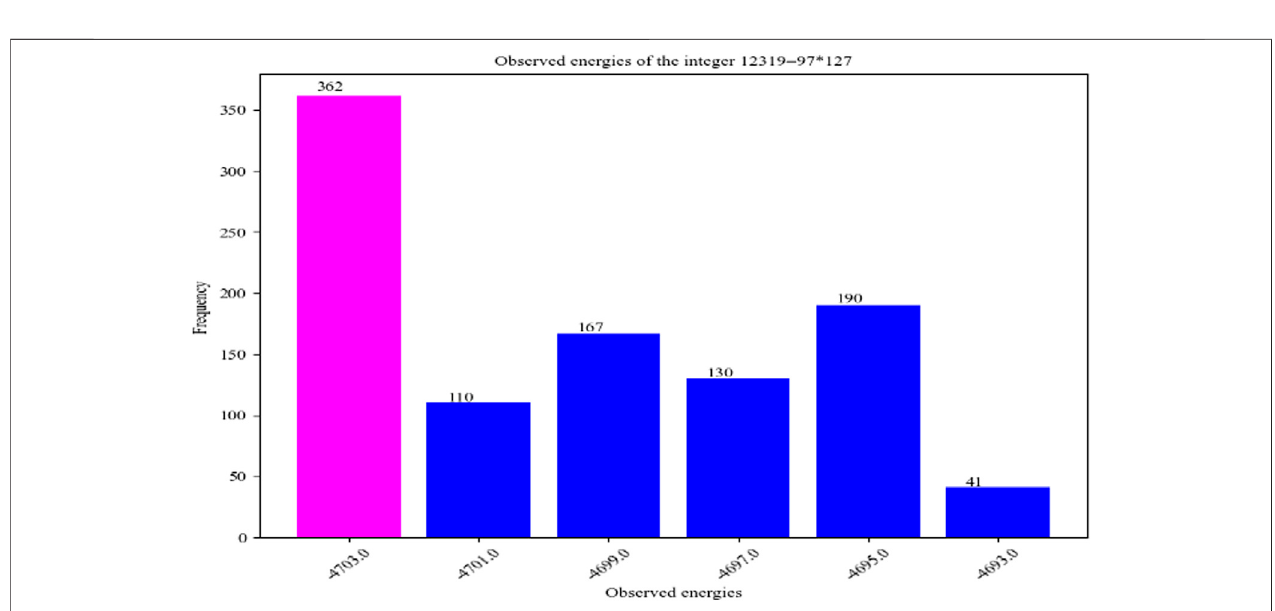
FIGURE 5 | Observed energies of 12319 = 97 × 127 after quantum